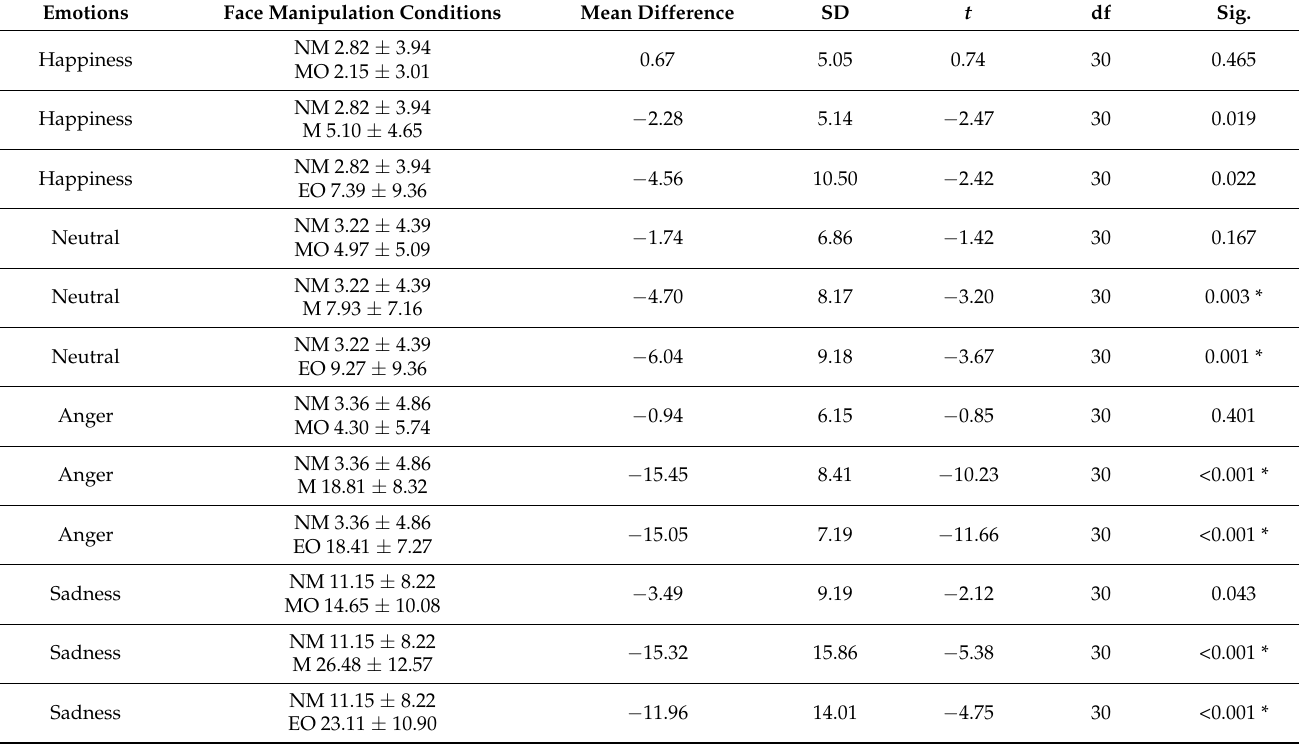
Figure 2. Error rates in face manipulation conditions for each emotion shown. * p -value ≤ 0.012. Table 2. Post hoc comparisons of error rates.